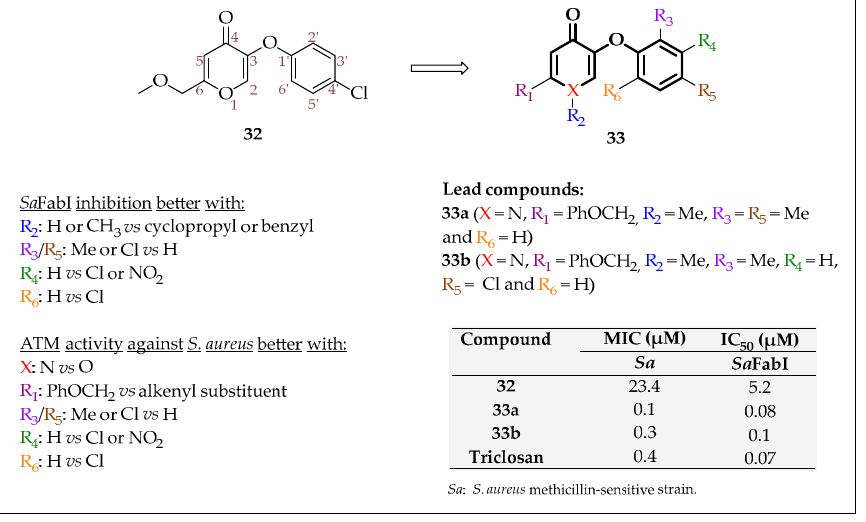
Figure 31. Structure and SAR of 32–33 and in vitro activities of lead compounds [145].